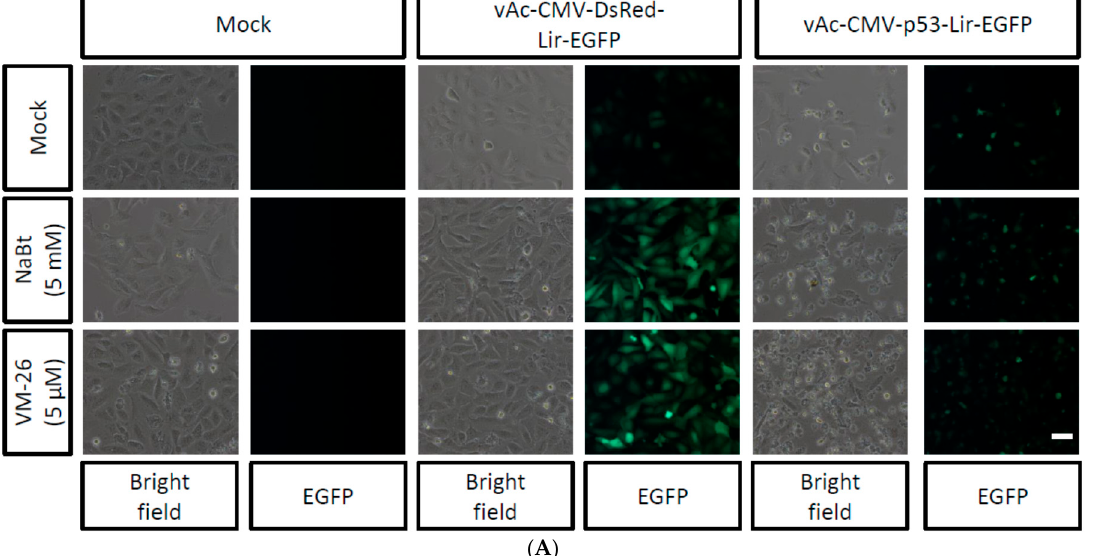
Figure 5. Cont. Figure 5.